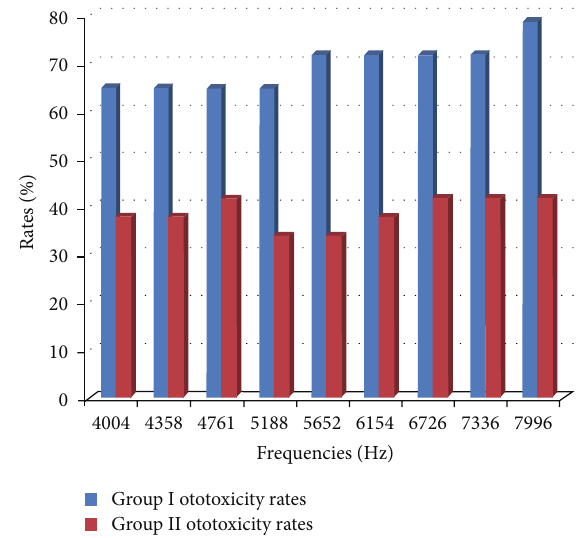
Figure 4: The occurrence of ototoxicity rates at the 10th day after cisplatin administration in groups I and